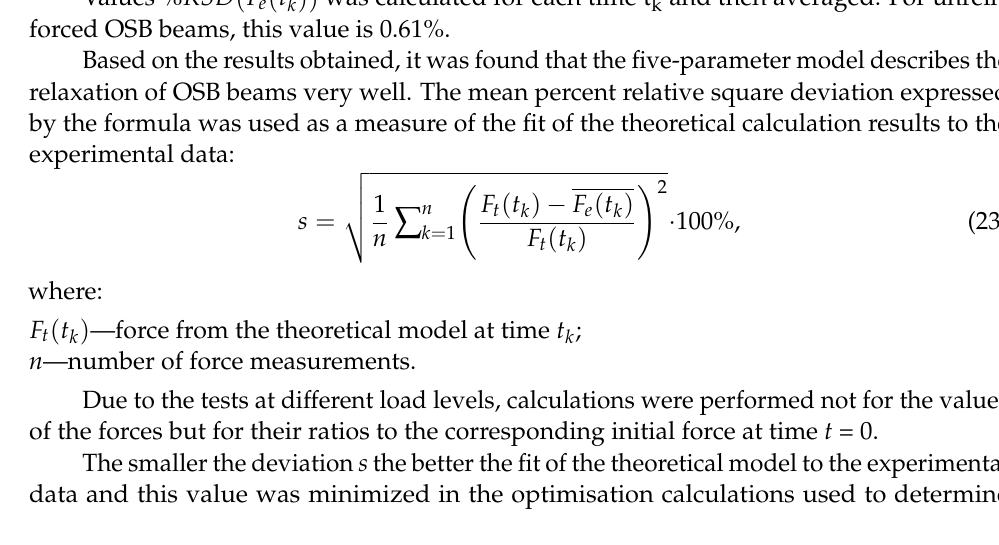
Figure 3. Experimental OSB beam relaxation functions, mean function, and theoretical model with parameter values.